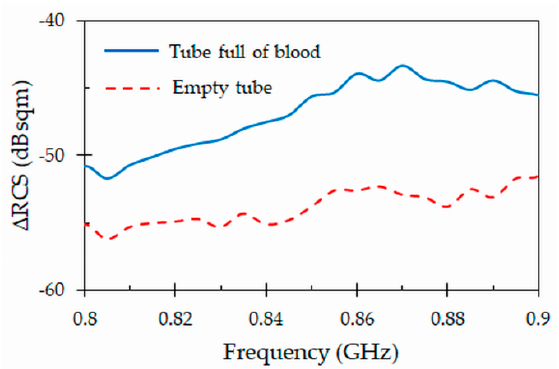
Figure 13. Measured differential radar cross section ( Δ RCS) for the proposed tag attached to full and empty blood tubes.